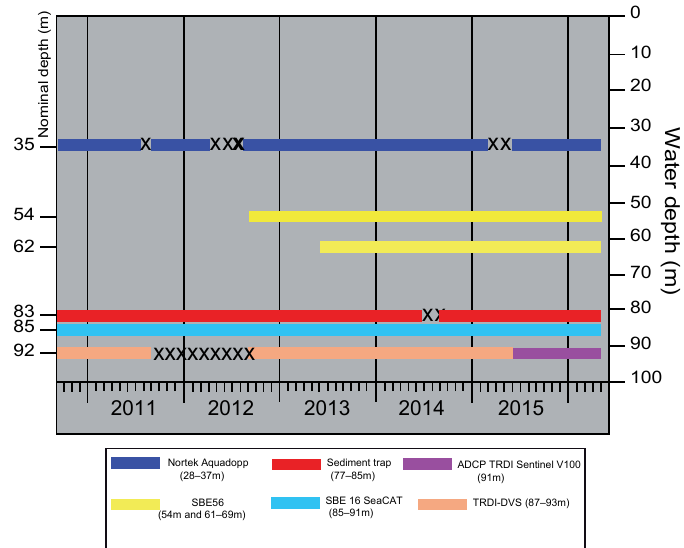
Figure A1. List of available time series for each instrument mounted on MDI in the period 2010–2016. No instrument was set at the surface because of the risk of damage from iceberg transit and sea ice coverage. The “X” symbol indicates an instrument